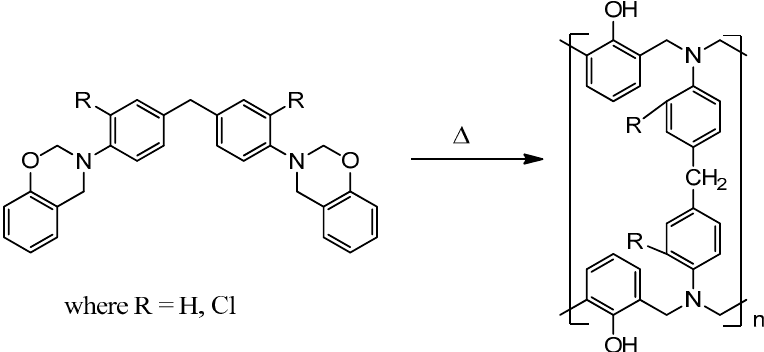
Figure 10. Scheme of polymerization of benzoxazine monomers.